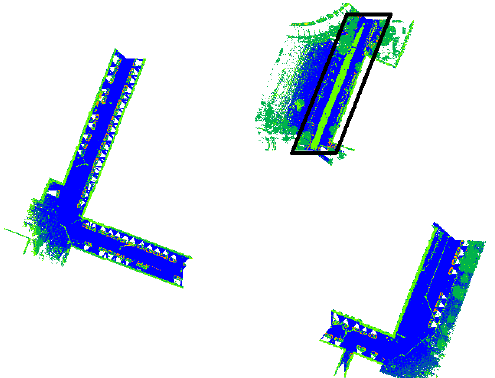
Figure 9. Testset 2: a part of the Gabelsbergerstrasse and of the TUM inner courtyard. served as the final test data for evaluating the fusion. Legend as presented in Figure 7